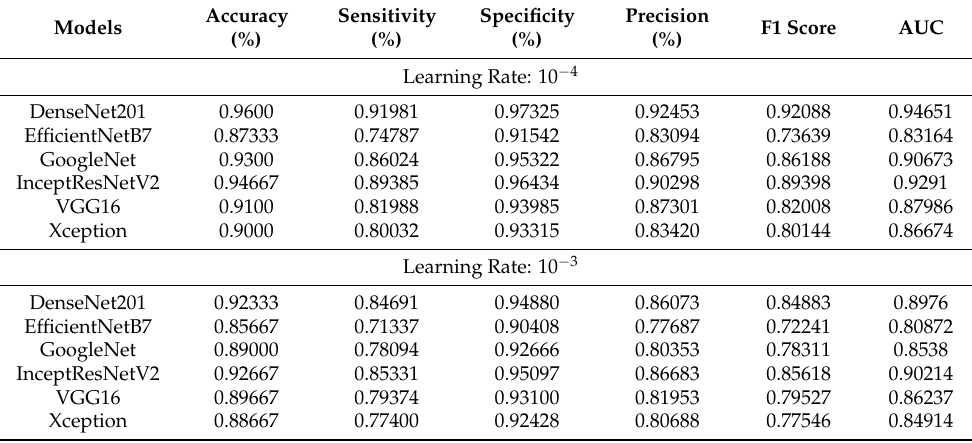
Table 4. Selection classification results of the Backbone model using